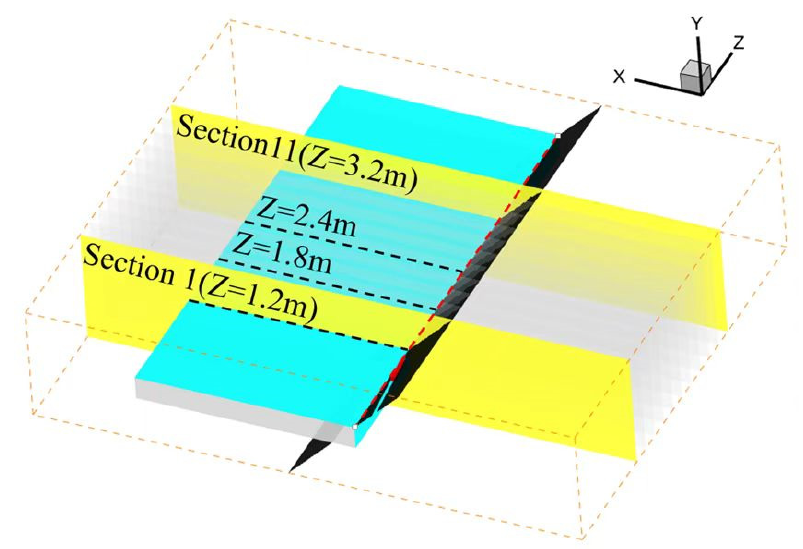
Figure 2. Schematic diagram of different sections.